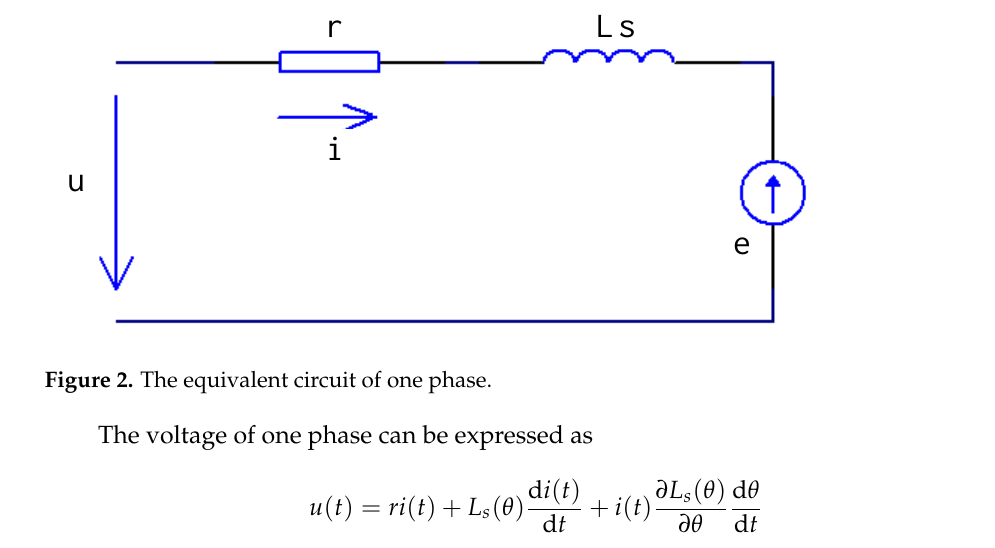
where L s the self-induction, the first item of (6) is resistance voltage drop, the second item is the potential induced by the change of flux linkage in phase winding caused by the change of rotor position, the third item is the back EMF, e ( θ ) which was caused by the change of current. The motor working in single channel mode can be regarded as a conventional HSM; in the case of two stator phases, the back EMF can be approximated by a sinusoidal function [28] as shown in